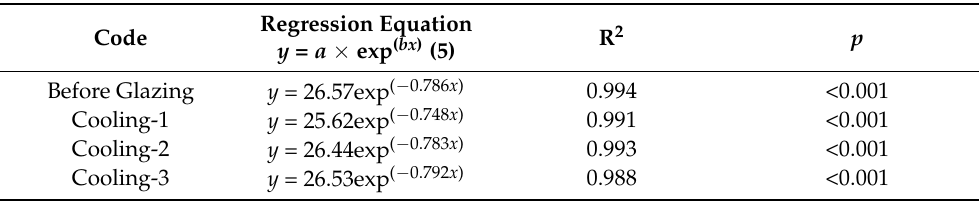
Table 7. Regression analysis of the relationship between the translucency parameter (TP) and thickness for each group of the zirconia specimens.